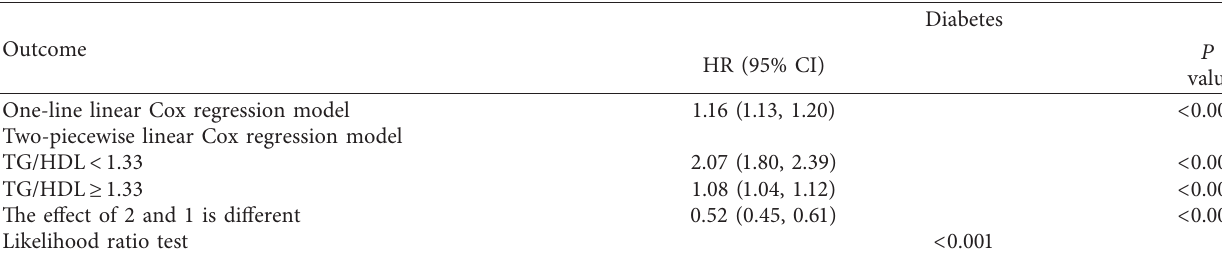
Table 4: Threshold effect analysis of TG/HDL on incident